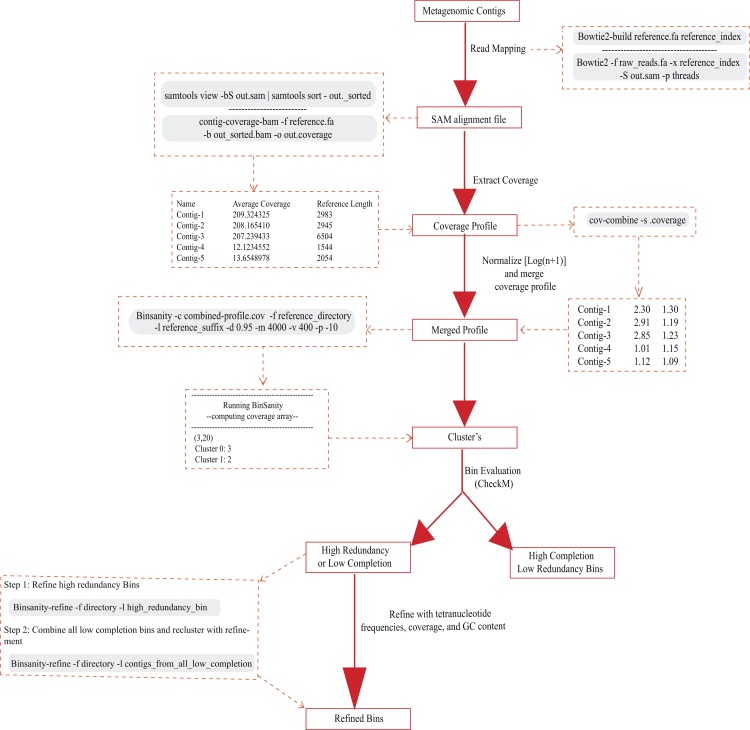
Workflow for Binsanity indicating all scripts used.